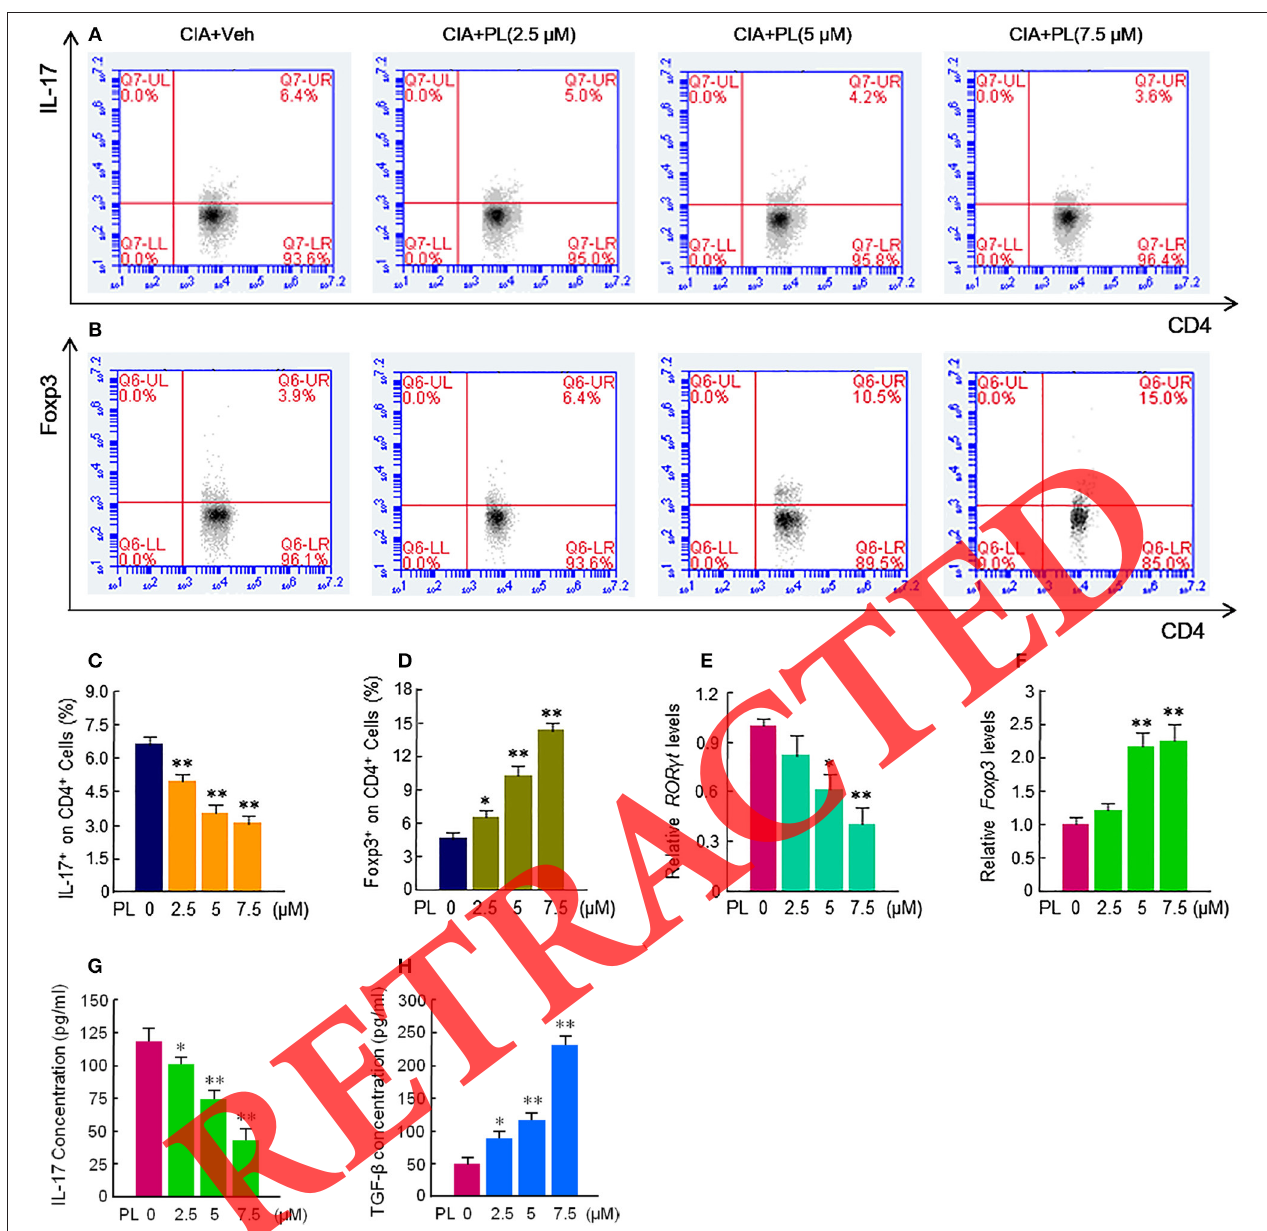
FIGURE 3 | Reciprocal effects of plumbagin treatment on Th 17 and Treg cell differentiation in vitro . Representative flow cytometry profile (A,B) and quantification (C,D) of IL-17 + and Fopx3 + cells in splenic CD4 + T cells isolated from CIA rats, which were cultured under Th17-polarizing conditions for 72h with or without plumbagin in different concentrations. (E,F) Gene expression of ROR γ t and Foxp3 as assessed by qRT-PCR of splenic CD4 + T cells isolated from CIA rats with different treatments. (G,H) Protein levels of IL-17 and TGF- β as measured by ELISA in the supernatants of CD4 + T cell cultures under different conditions. Quantitative results are presented as mean ± SEM, and n = 5/group. * P < 0.05; ** P < 0.01 vs. vehicle-treated CIA